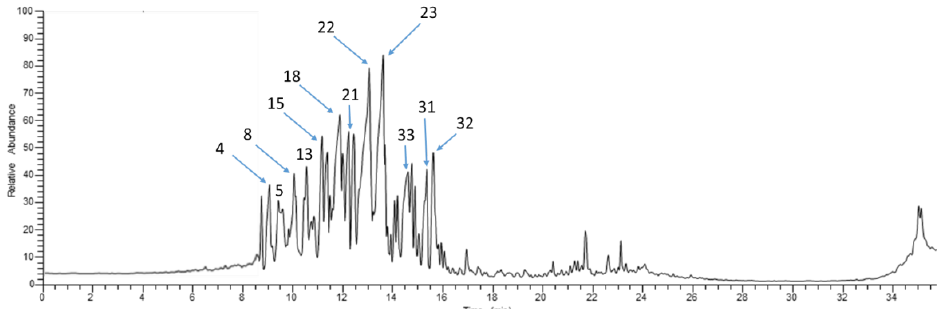
Figure 1. Representative total ion chromatograms of volatiles acquired from tea tree oil via GC-MS. For peak numbers, refer to Table 1. Table 1. Relative percentage of volatiles in tea tree oil specimen ( n = 3) by GC-MS analysis.